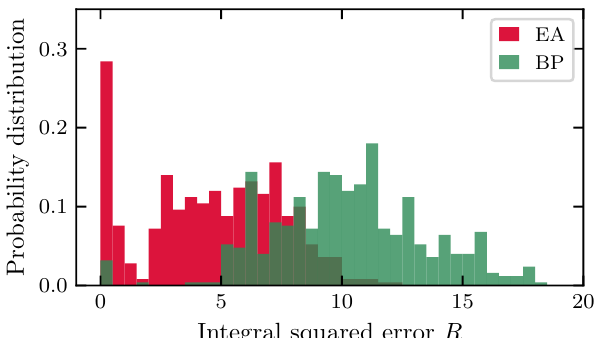
Figure 3. Error probability distribution comparison between EA and BP algorithms for constant estimation based on 20 data points.